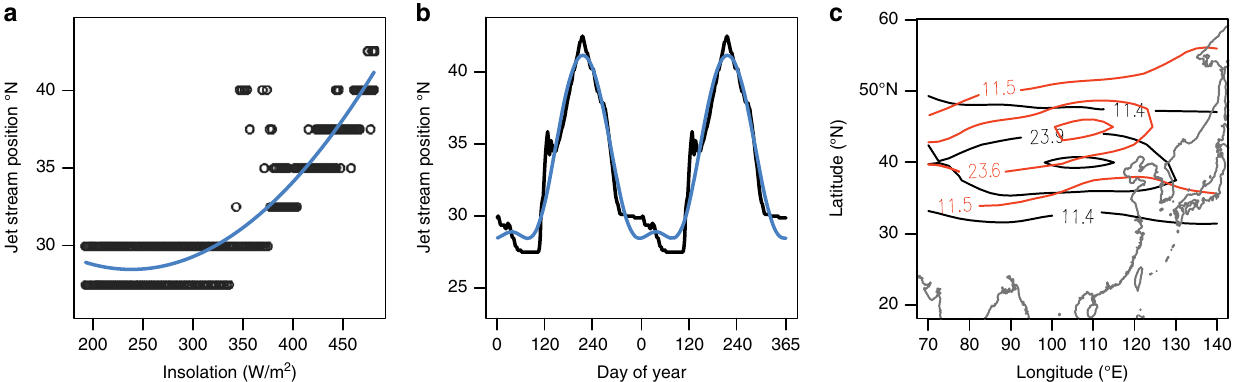
Fig. 2 Modern relationship between insolation and the position of the westerly jet stream, and modeled Holocene winds: a relationship between the daily climatological position of the westerly jet stream and daily insolation levels (black), and the fi tted second-order polynomial (blue); b observed (black) and predicted (blue) annual cycles in the position of the westerly jet stream; c modeled 250 hPa wind for 2 ka (black) and 9 ka (red) on the day of the year when the westerly wind stream reached its most northerly position, indicating the position and orientation of the westerly jet stream during the early Holocene compared with the late Holocene (for version with wind vectors see Supplementary Fig.